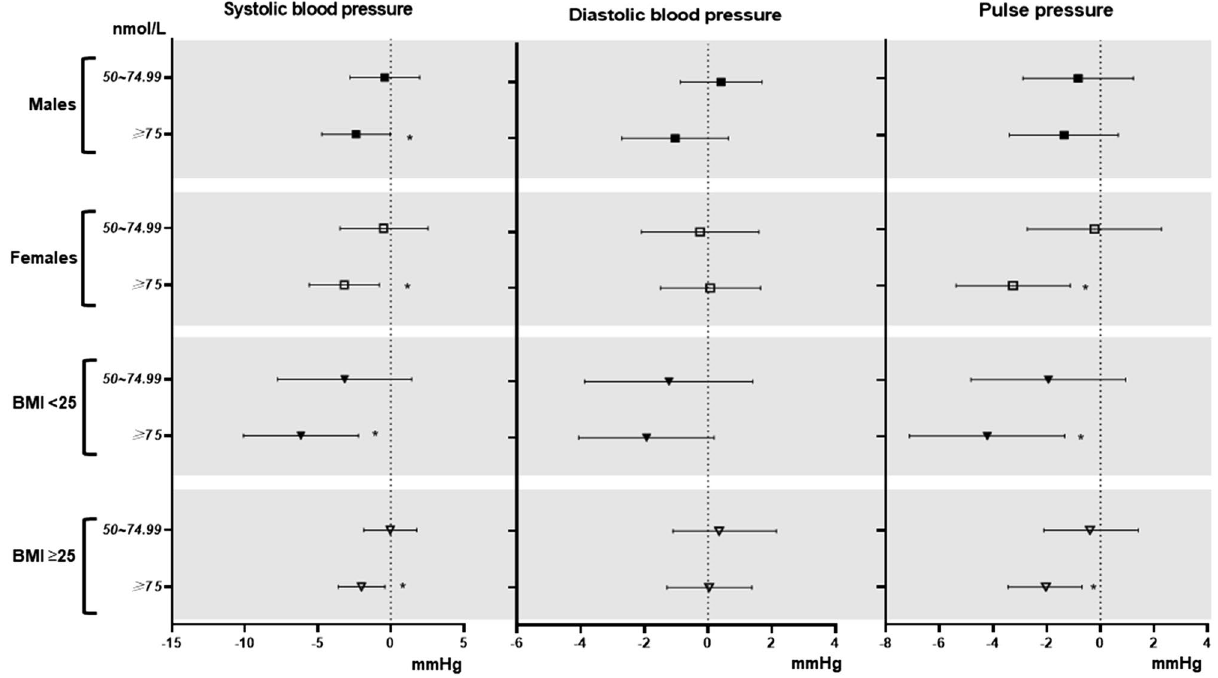
Figure 1. Multiple linear regression of blood pressure with vitamin D concentrations in the subgroups by sex and BMI. p -trend < 0.05 considered significant. Adjusted for age, sex, race/ethnicity, education, season of examination, physical activity, alcohol consumption, smoking status, dietary covariates (intakes of total energy, potassium, calcium, magnesium, and sodium), height, weight, and